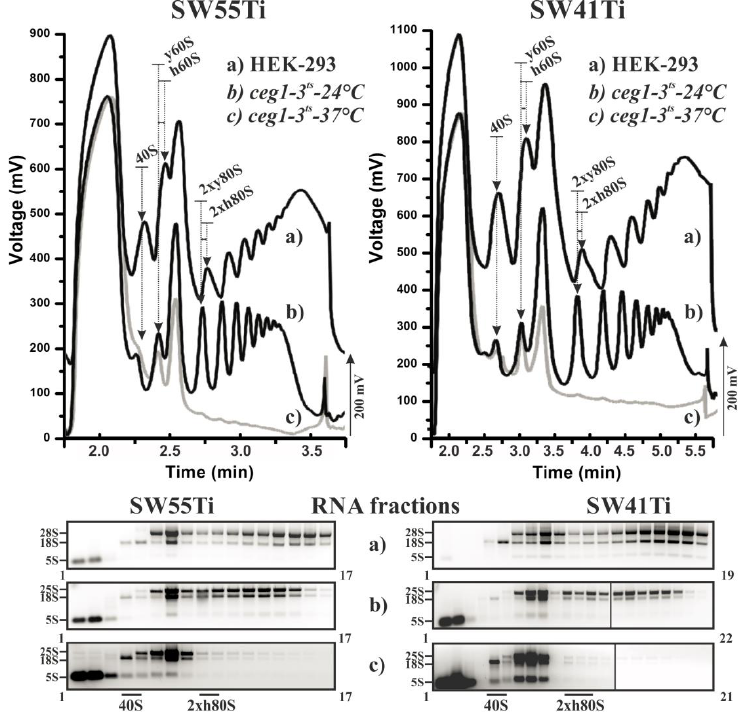
Figure 1. Performance of polysomal profiling in SW55Ti centrifugation tubes. Identical cell lysates from HEK-293 cells (a) and yeast strain W303 ceg1 ts cultivated either at 24 °C (b) or 37 °C (c) were loaded on 10%–50% sucrose gradients prepared either in SW55Ti tubes (left panels) or SW41Ti tubes (right panels). RNA was isolated from equal fractions of the respective profiles and loaded on agarose gel (lower panels). Individual fraction numbers are indicated next to each electrophoretogram. Note in upper polysome profiles the obtained HEK-293 curves are shifted up by 200 mV to prevent overlapping with the yeast derived data curves. Arrows indicate the position of specific peaks within the profiles: i.e., 40S, small ribosomal subunits; 60S, large ribosomal subunits; and 2 × 80S, low molecular weight polysomes consisting of two ribosomes; h denotes human and y signifies yeast ribosomal subunits / polysomes. To the left of each electrophoretogram are denoted the positions of rRNAs in corresponding gels (note, the 5S rRNA label denotes the collective positions of 5.8S rRNA, 5S rRNA and tRNAs in